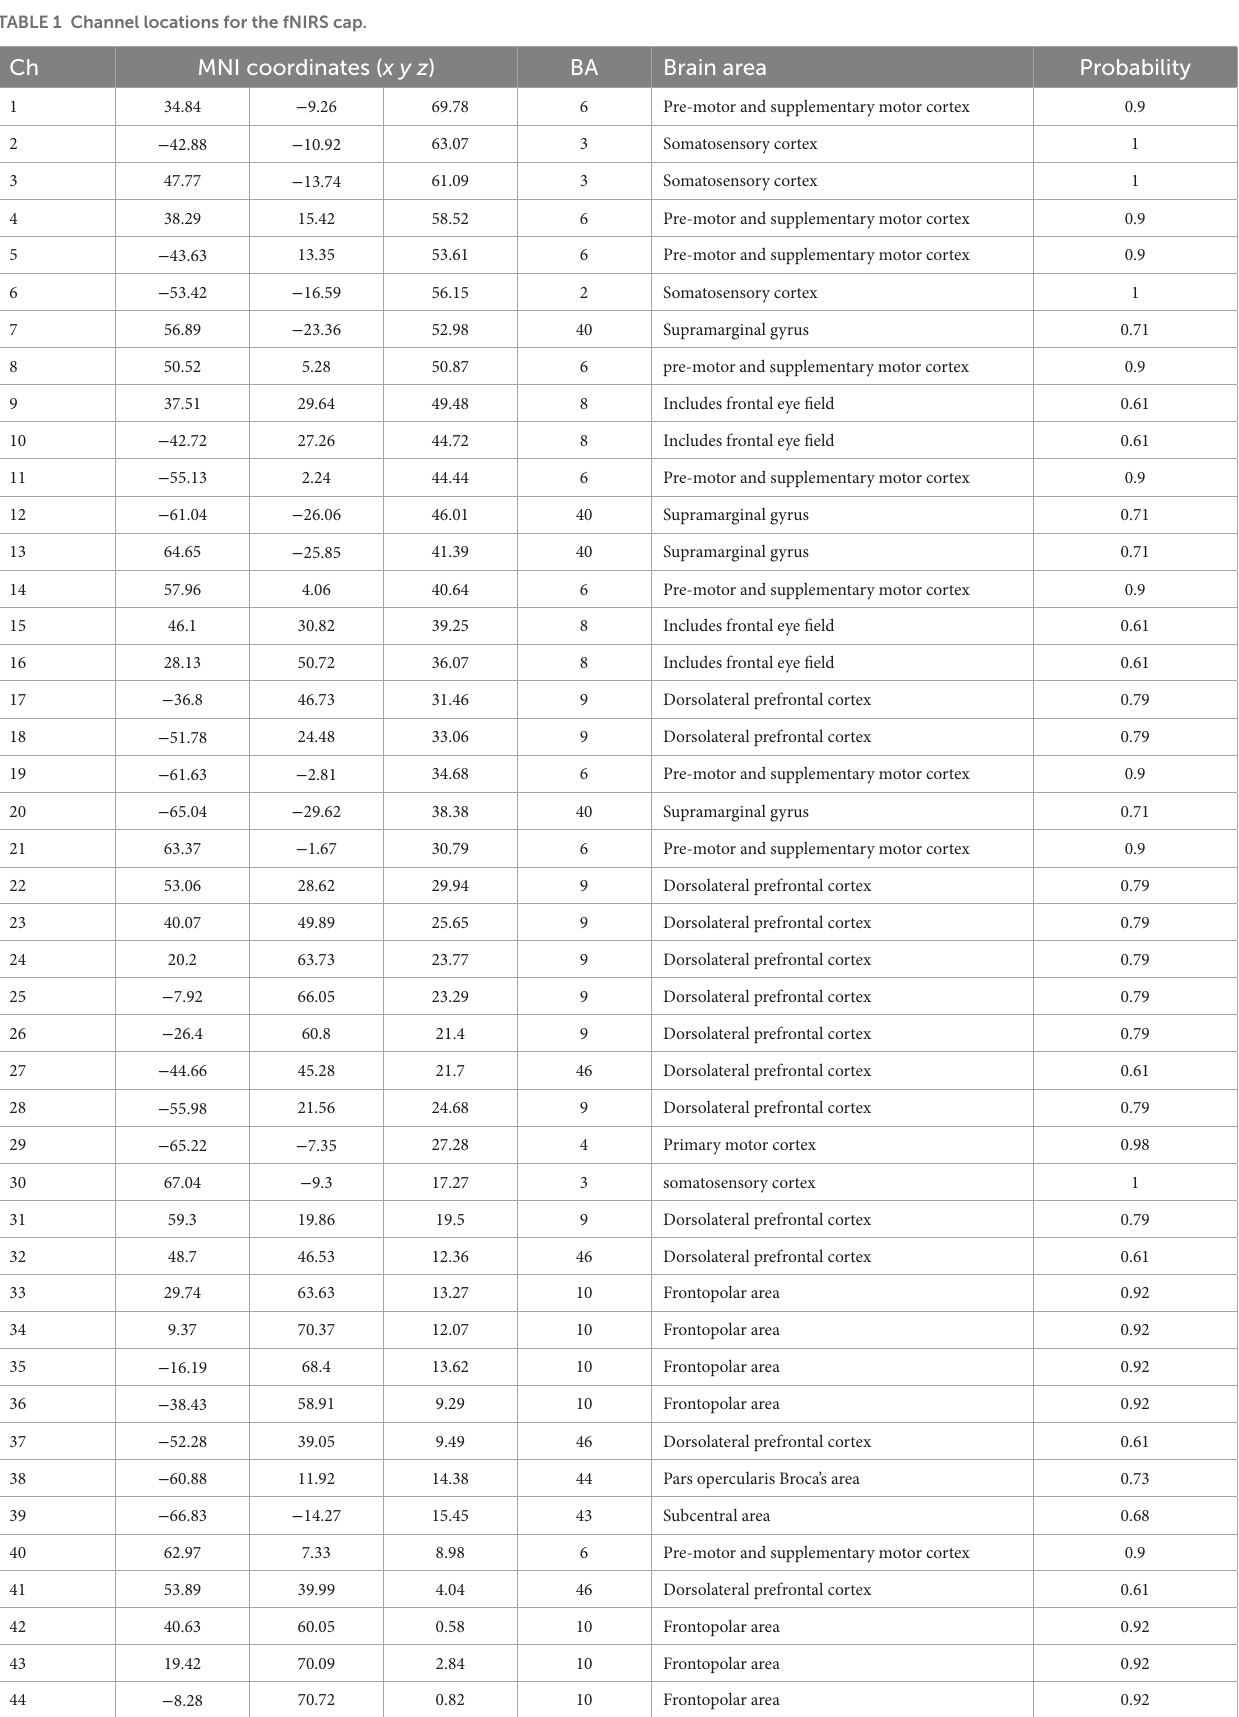
TABLE 1 Channel locations for the fNIRS